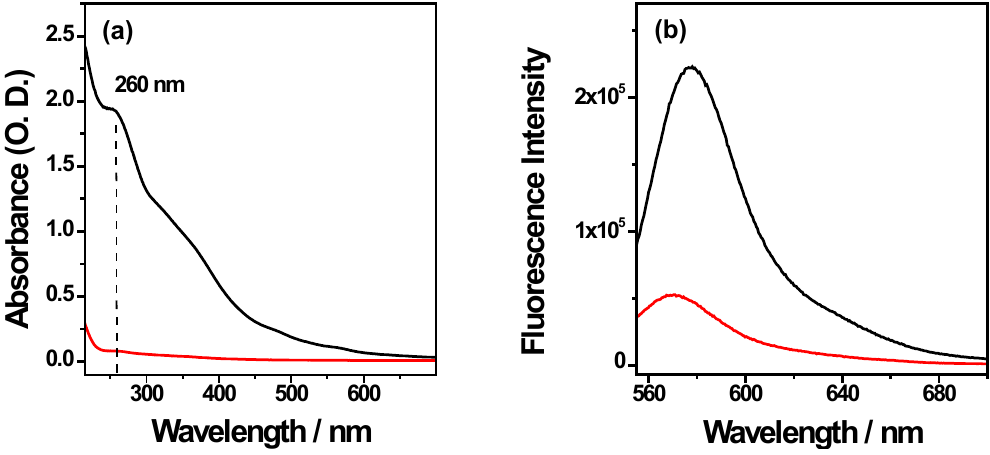
Figure 6. ( a ) UV-visible and ( b ) fluorescence spectra of the supernatants (red line) and the nanocomplexes (black line) in water at pH 7.